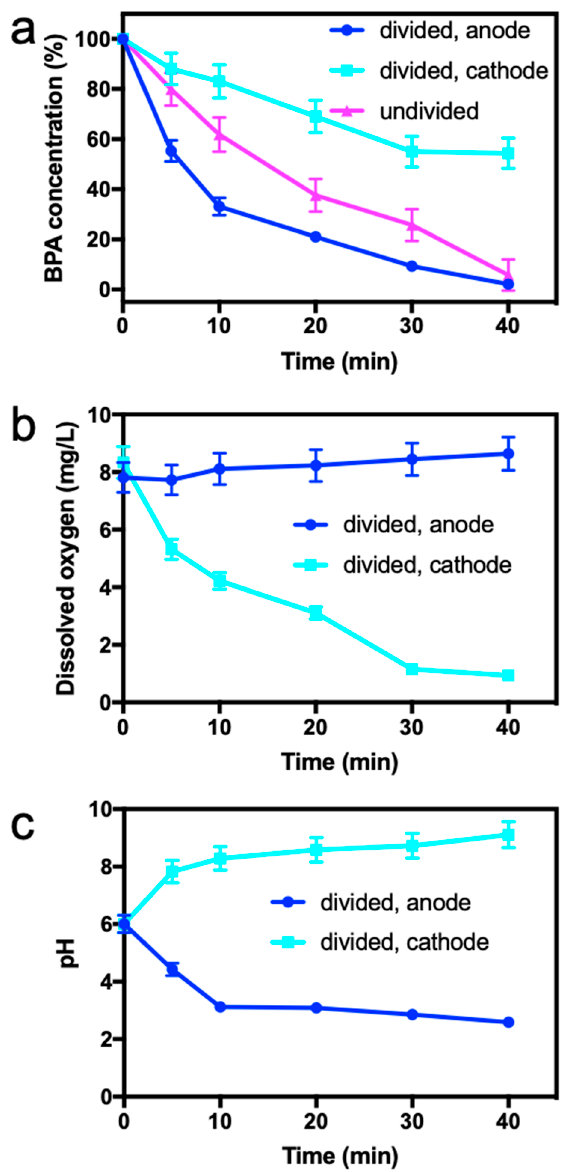
Figure 3. Removal of BPA by the electro/Mn(II)/sulfite process in divided electrochemical cell. ( a ) BPA removal by the electro/Mn(II)/sulfite process in anode and cathode chambers and undivided electrochemical cell; ( b ) dissolved oxygen in the solution changes in anode and cathode chambers; and ( c ) solution pH changes in anode and cathode chambers. Reaction conditions: 0.2 mM Mn(II), 2 mM sulfite, 5 mM sulfate as supporting electrolyte, 10 µ M BPA, 100 mA electric current, and pH 6.